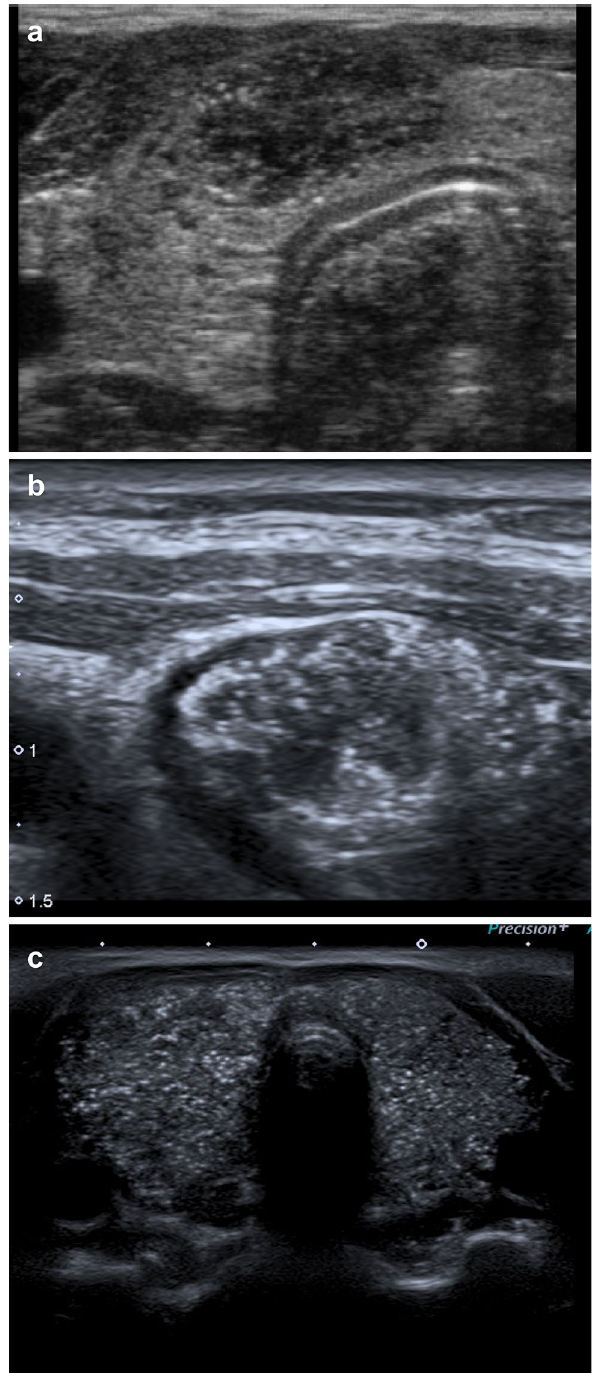
Figure 4. (a–c) Ultrasonographic presentation of papillary thyroid carcinoma. ( a ) A solitary hypoechogenic nodule with subcapsular localization, irregular borders and multiple microcalcifications in an adolescent boy with coexisting autoimmune thyroiditis. ( b ) A solitary hypoechogenic nodule with subcapsular localization and multiple microcalcifications in an adolescent girl with coexisting Graves’ disease. ( c ) Multiple disseminated microcalcifications in an adolescent girl with hypoechogenic thyroid gland and coexisting autoimmune thyroiditis (multifocal diffuse sclerosing